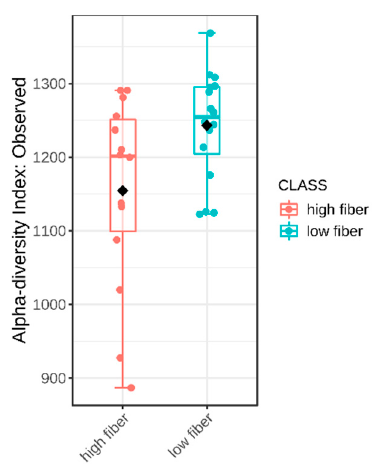
Figure 6. Alpha diversity of intestinal microbiota in children with ASD with high and low daily fibre intake, p = 0,037.